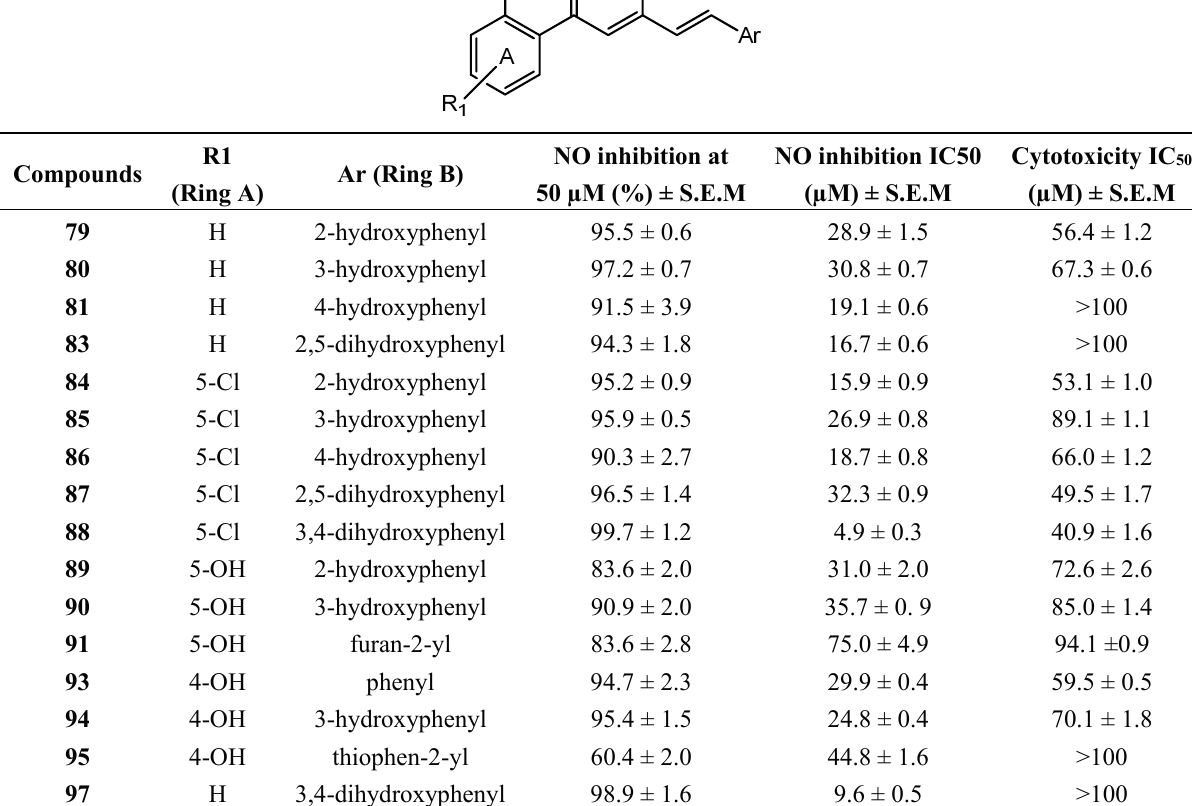
Table 4. NO suppression activity and cytotoxicity of active polyphenolic diarylpentenedione analogues on RAW 264.7